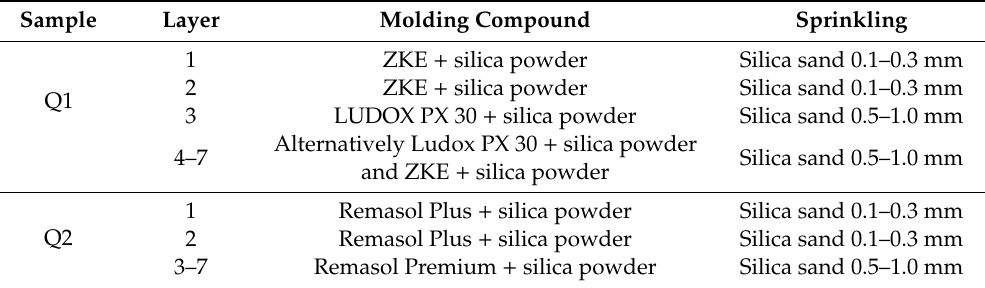
Table 1. Raw material compositions of the produced samples.